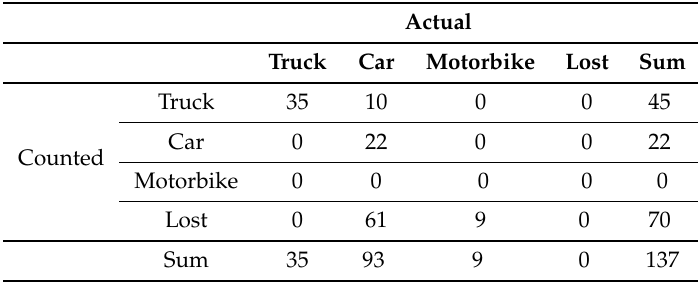
Table 7. Counting results per vehicle type from the confederation bridge with 250 ms request interval.